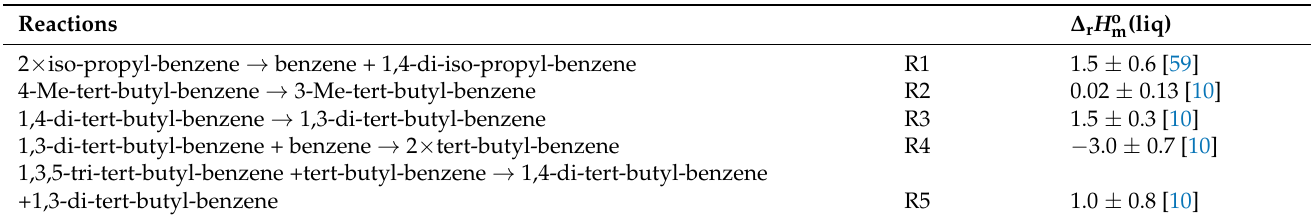
Table 9. Results of chemical equilibrium studies of interconversions of alkylbenzenes at T = 298.15 K ( p ◦ = 0.1 MPa, in kJ · mol − 1 ) a